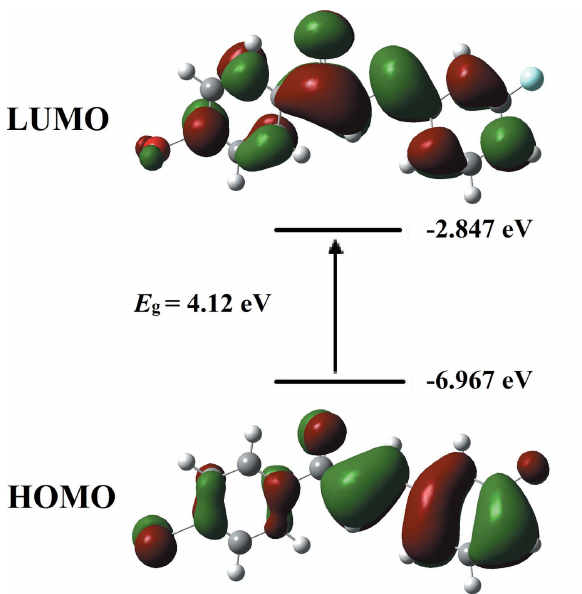
Figure 6 Molecular orbitals showing the HOMO–LUMO electronic transitions in the title compound.